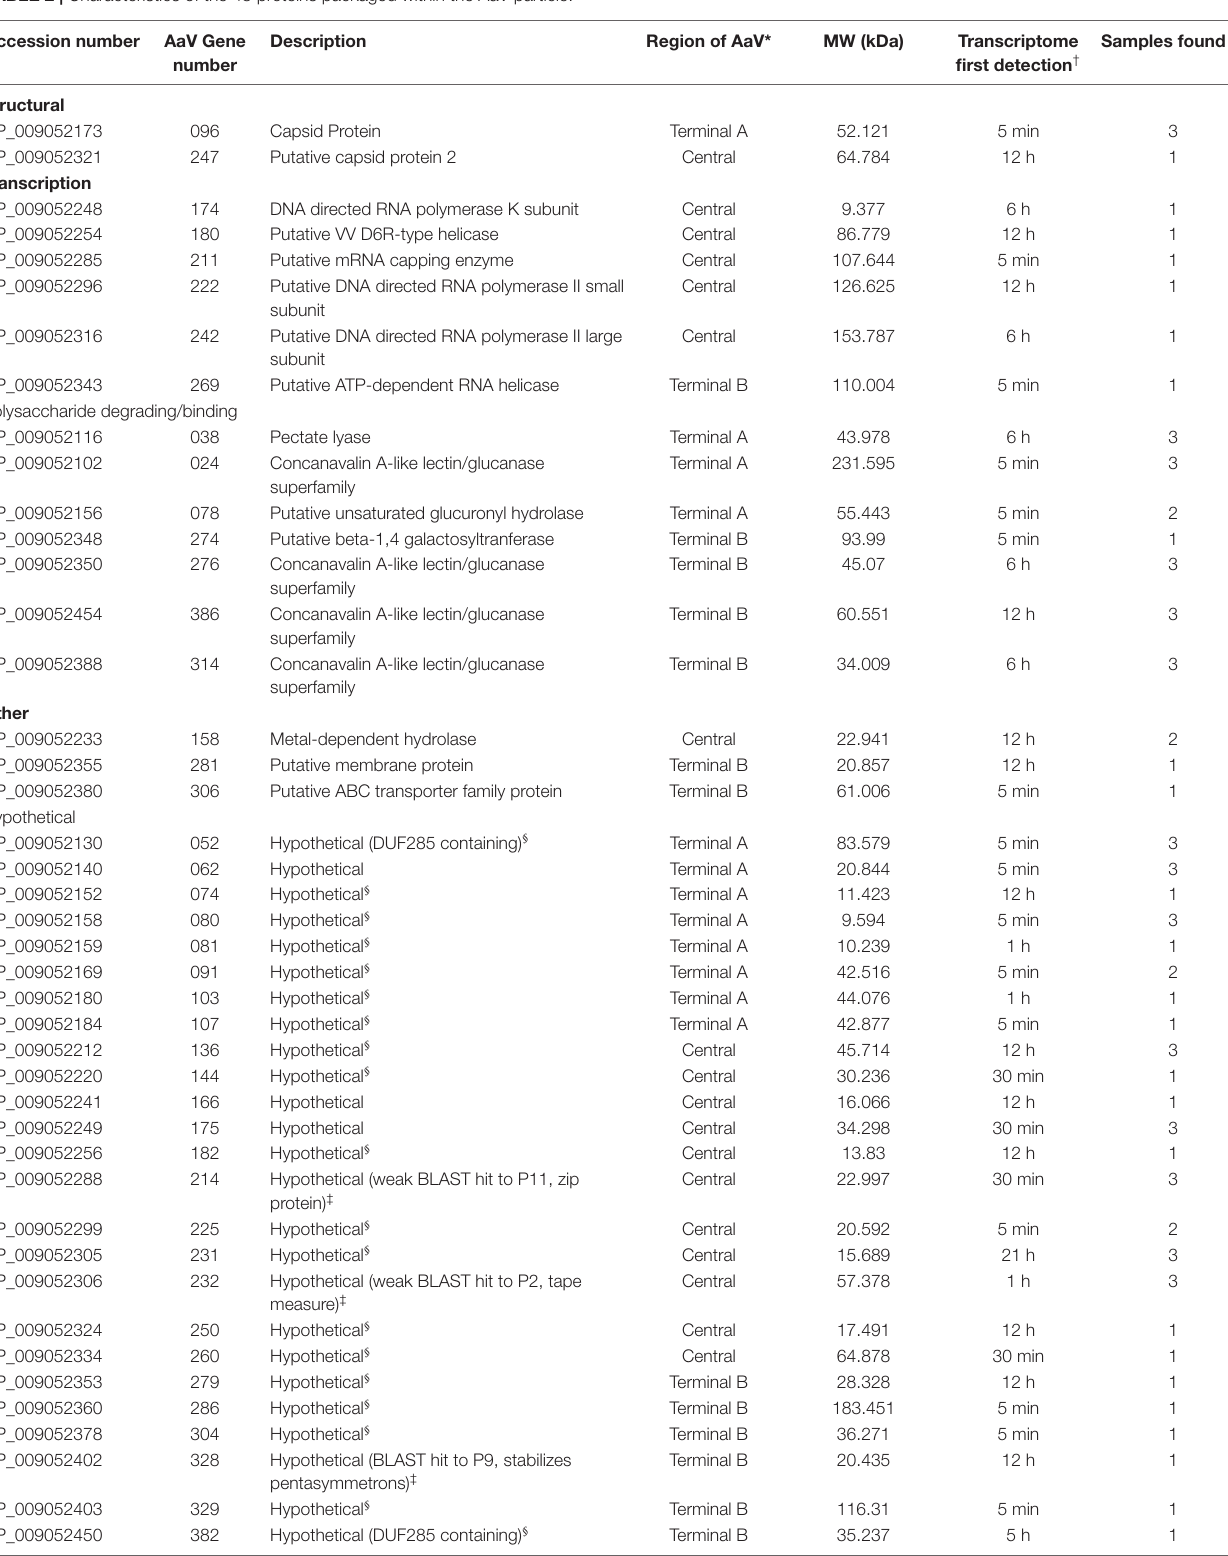
*Region of AaV is based description from the initial characterization of the genome (Moniruzzaman et al., 2014). † Data from the transcriptome of the infection cycle (Moniruzzaman et al., 2018). ‡ BLAST results against the minor structural proteins determined by the reconstruction of the PBCV-1 particle (Fang et al., 2019). § Hypothetical proteins that have no BLAST hits in